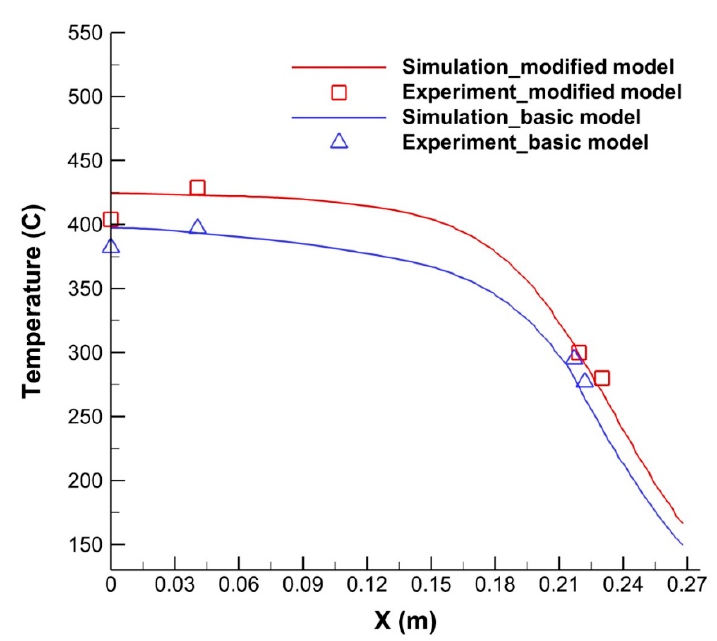
Figure 17. Comparison of the temperature distribution at the back side of the steel plate from the center to the edge for complete combustion.